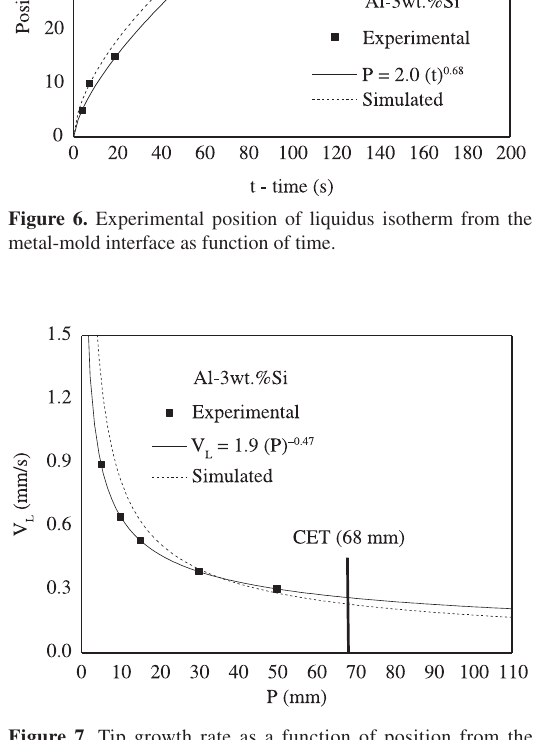
Table 3. Experimental and numerical results for the solidification thermal parameters associated to the CET position.